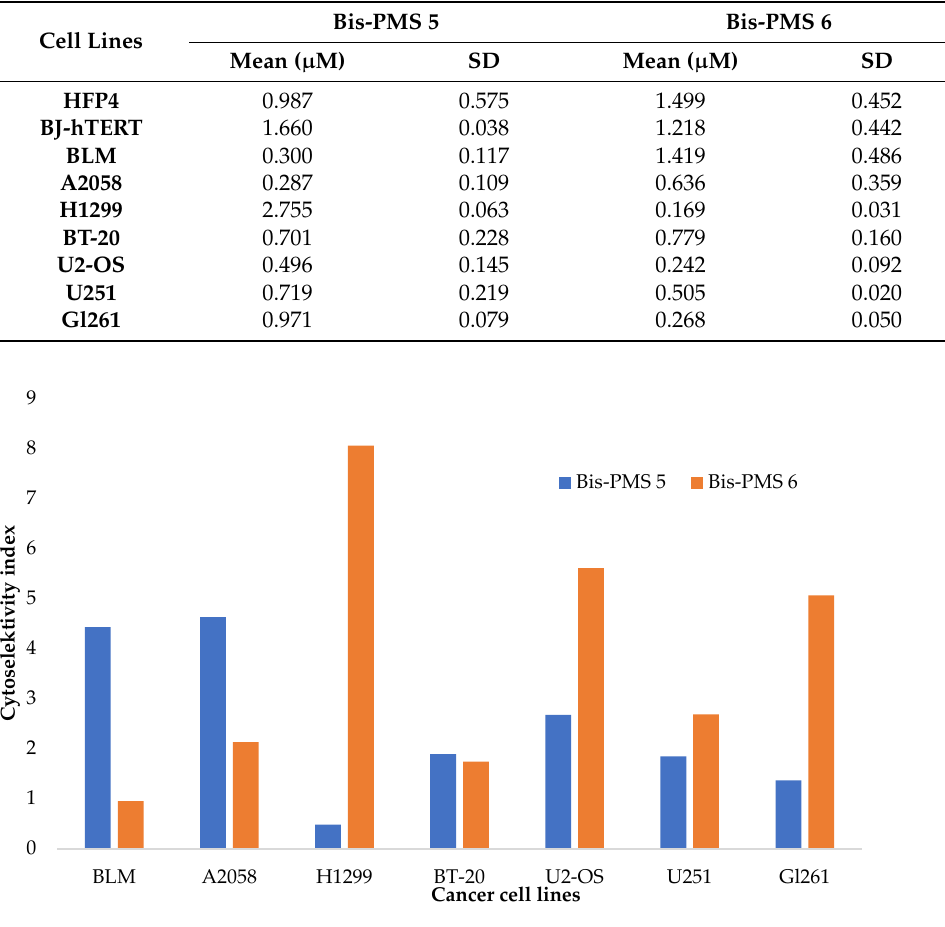
Figure 5. Cytoselectivity of Bis-PMSs 5 (blue) and 6 (orange) for cancer cell lines (BLM and A2058 human melanoma cells, H1299 human non-small cell lung cancer cells, human BT-20 breast cancer cells and U2 ‐ OS human osteosarcoma cells) against normal cells (HF P4 and BJ ‐ hTERT human fibroblasts). For U251MG and Gl261 glioblastoma cells, the cytoselectivity was calculated against normal HF P4 fibroblast cells, which were analyzed using the same cytotoxicity assay. Bis ‐ PMS 6 exhibited higher toxicity in most tested cell lines (Table 1). The cellular